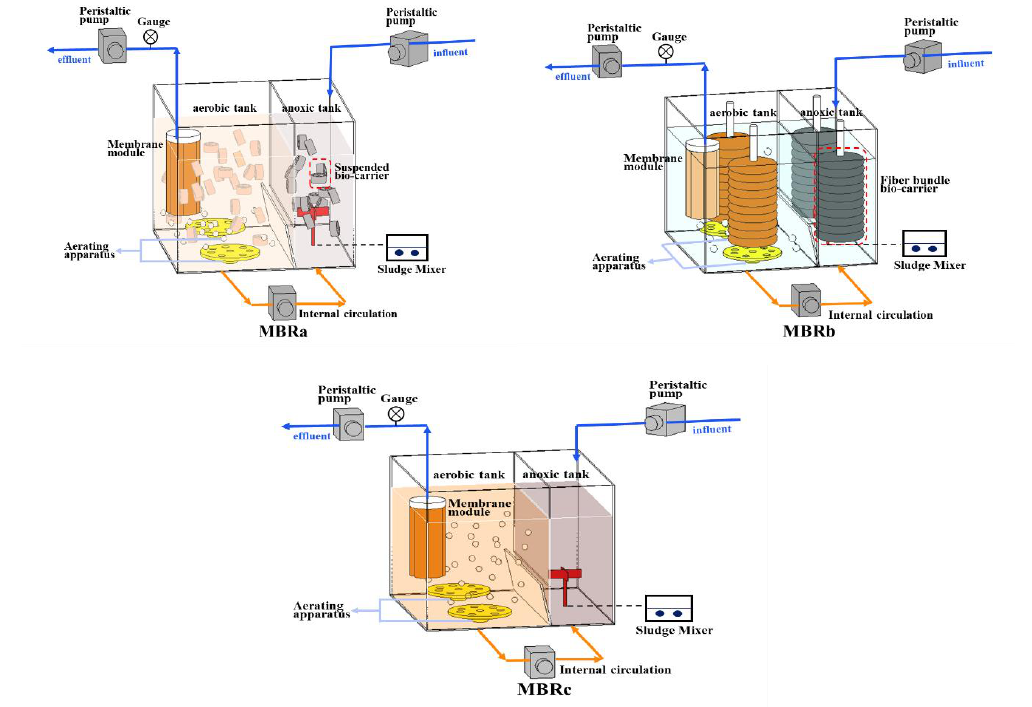
Figure 1. Configurations of membrane bioreactors MBRa, MBRb, and MBRc.